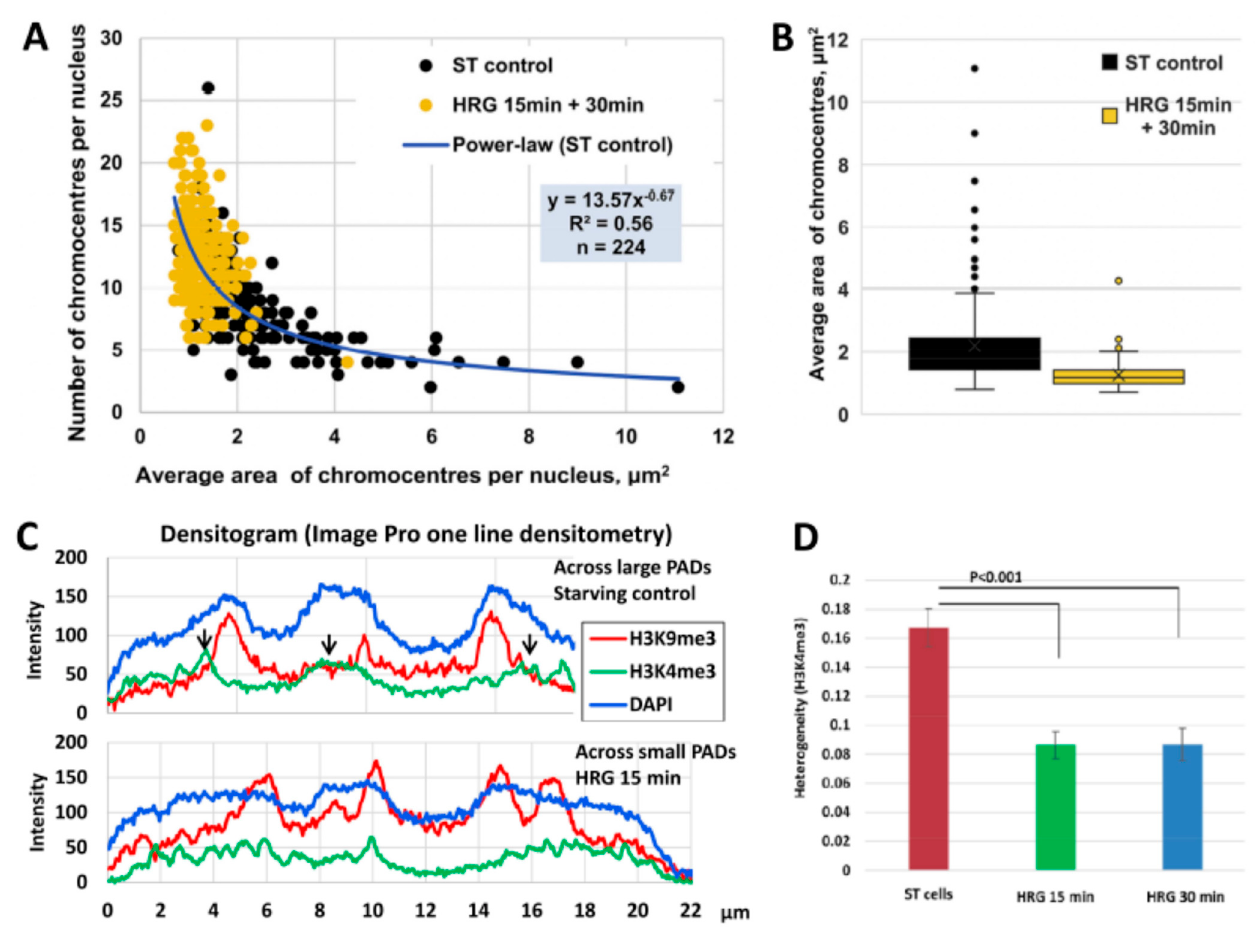
Figure 8. Influence of HRG treatment (15 and 30 min) on PAD distribution in ST (starving) control cells. ( A ) Relationship between the average number of PADs and their average area per cell; the distribution clearly shows the transition of both HRG 15- and 30-min cells covering only a small area in the ST population. The data of the three experiments are merged. ST control cells show a power-law distribution with high correlation (blue trendline); ( B ) box plots of the data presented in panel ( A ) showing high heterogeneity of the PADs in ST control cells and low heterogeneity and ~50% lower average area in HRG 15- and 30-min samples; ( C ) three-line mean densitometry examples: in the upper scan across large PADs in starving control and in the lower image across small PADs at HRG 15 min in the double-immunostained H3K9me3/H3K4me3 chromatin, counterstained with DAPI (recorded in corresponding optical channels), revealing in the upper scan the relatively dense H3K4me3 “collars” (arrows) at the borders and admixed in PADs included in larger DAPI-dense chromocenters, while in the lower scan the H3K4me3-positive material seems repulsed from PADS and distributed more evenly, decreasing the density of the DAPI chromocenters; ( D ) HRG treatment induces unfolding of the H3K4me3-positive chromatin. The results of the measurements of the heterogeneity parameter of the H3K4me3-stained, transcriptionally active chromatin are shown in the green channel using ImagePro Plus 4.5 program. After 15 min of HRG treatment, the active chromatin becomes 50% less heterogeneous (smoothened) and remains such at 30 min of HRG treatment. Averages of three independent experiments, with standard deviation. (Note: These figures and modified figure legends were originally published under CC-BY license in